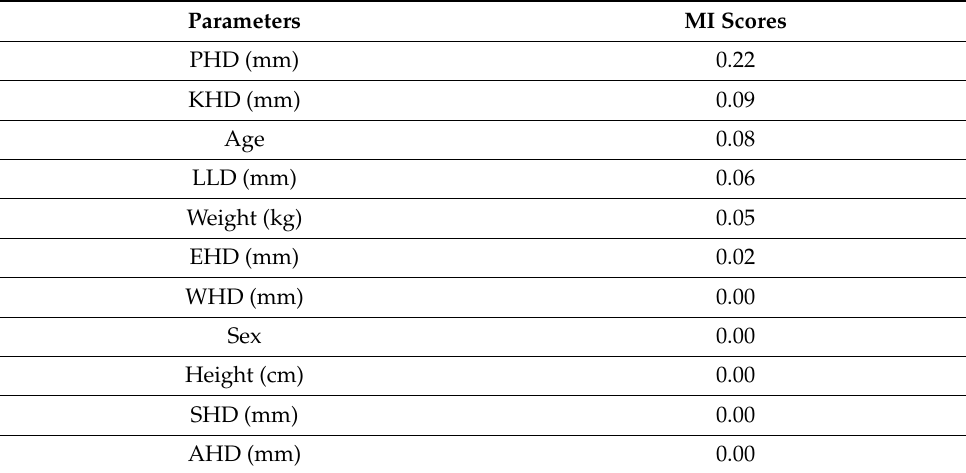
Table 4. The mutual information (MI) of the